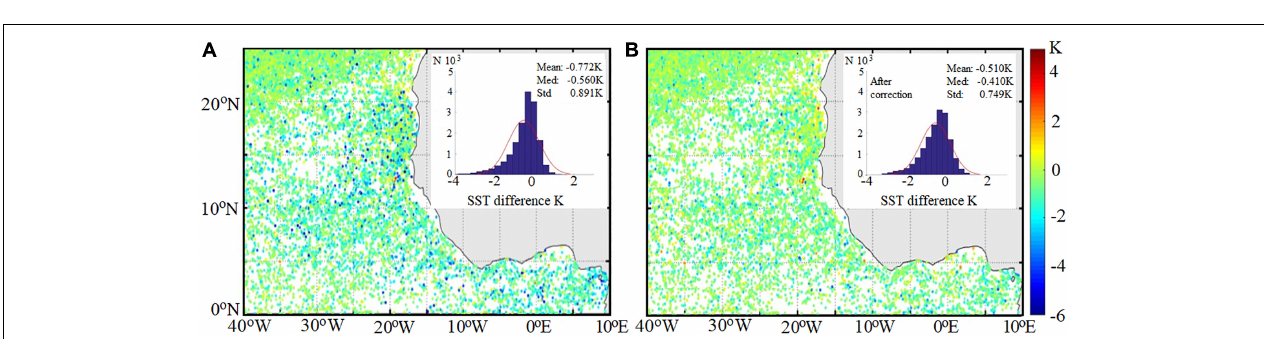
FIGURE 3 | An example of using the temporal context information available from the ABI on GOES-16. The image at lower left is the sampled instantaneous SST at 17UTC. At lower right is collated SST, produced using an algorithm described in Gladkova et al. (in review) that examines 6 h of temporal data to detect residual cloud from drop-outs in the SST time series, and to fill short temporal gaps by noise-tolerant curve fitting. The collated product significantly increases clear-sky coverage, and reduces cloud leakages and noise in the imagery. (Reproduced by permission under CC BY 4.0 from http://doi.org/10.6084/m9.figshare.7286267.v2).